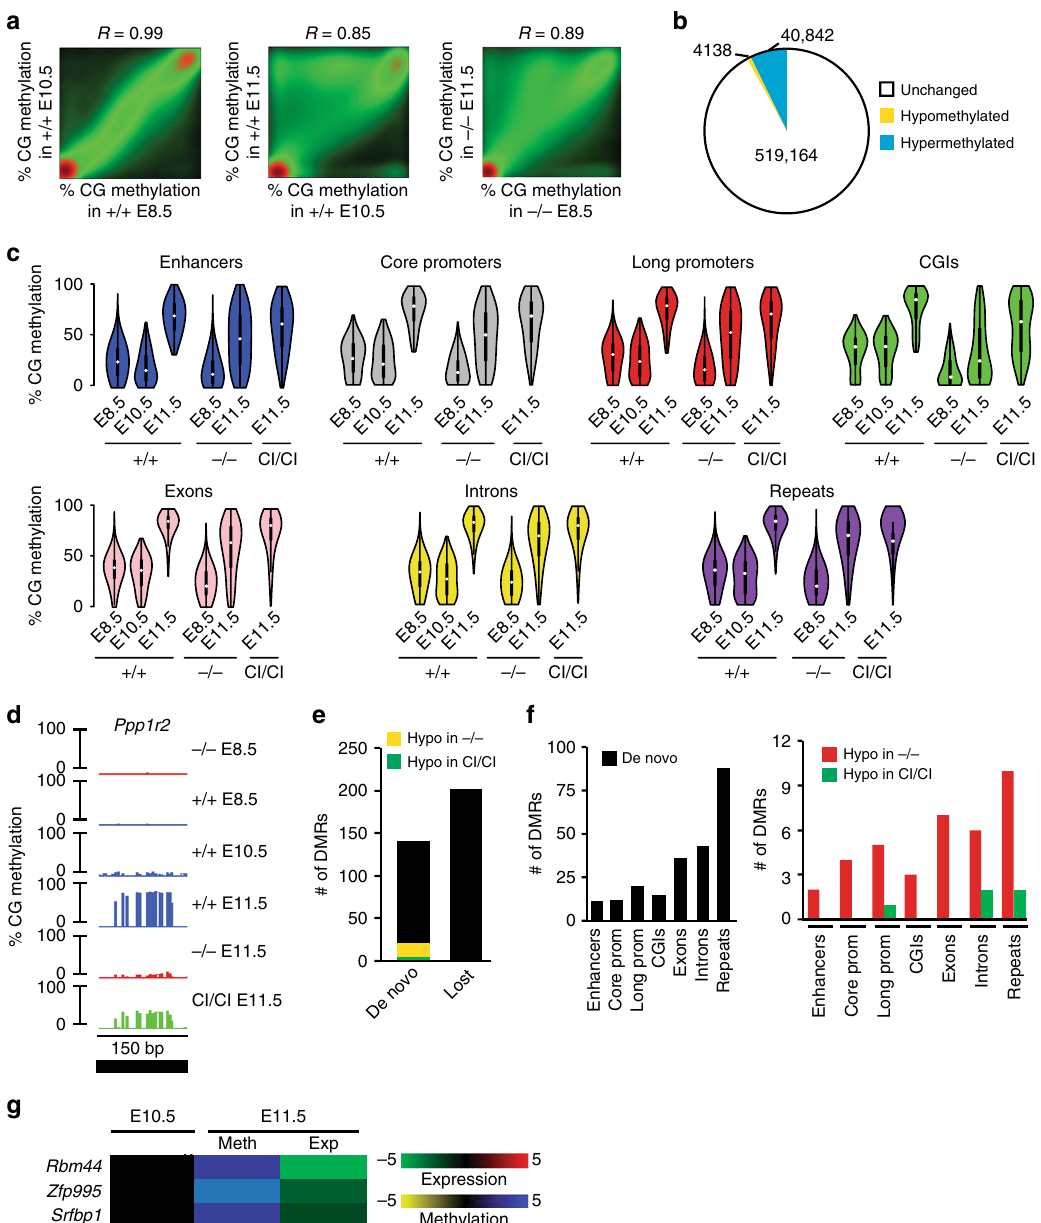
Fig. 5 Methylation changes at E11.5 are partially mediated by Dnmt3b. a Pairwise comparison of CG methylation in Dnmt3b + / + embryos at E8.5 and E10.5; E10.5 and E11.5 and Dnmt3b − / − embryos at E8.5 and E11.5. The density of points increases from green to red. R- values represent Pearson correlation coef fi cients. b Total number of differentially methylated CGs in Dnmt3b + / + embryos at E11.5 relative to E10.5 (meth diff. ≥ 30%). c Violin plots showing CG methylation in Dnmt3b + / + embryos at E8.5, E10.5, and E11.5, Dnmt3b − / − embryos at E8.5 and E11.5, and Dnmt3b CI/CI embryos at E11.5 in indicated genomic elements. d Visualization of single-CpG pro fi les at de novo methylated locus of Ppp1r2 that remains hypomethylated in Dnmt3b − / − and Dnmt3b CI/CI embryos at E11.5. Visualization of single-CpG pro fi les at Evc2 locus that maintains methylation across E8.5 – E11.5 in Dnmt3b + / + and loses methylation in Dnmt3b − / − . e The total number of hypermethylated (de novo) and hypomethylated (lost) DMRs identi fi ed in Dnmt3b + / + embryos at E11.5 relative to E10.5 ( n = 2 for each timepoint) (methylation diff. ≥ 30%; p (MWU) <0.05). Out of de novo methylated DMRs, those which are hypomethylated in Dnmt3b − / − and Dnmt3b CI/CI relative to Dnmt3b + / + embryos at E11.5 are marked yellow and green, respectively. f Total number of hypermethylated (de novo) DMRs identi fi ed in Dnmt3b + / + embryos at E11.5 relative to E10.5 within indicated genomic elements (left panel). Out of these, DMRs which are hypomethylated in Dnmt3b − / − and Dnmt3b CI/CI embryos relative to Dnmt3b + / + at E11.5 are marked red and green, respectively (right panel). g Heat map of genes de novo methylated within promoter or enhancers and downregulated (FC ≥ 2; p < 0.05 by DESeq) in Dnmt3b + / + embryos at E11.5 relative to E10.5. Source data